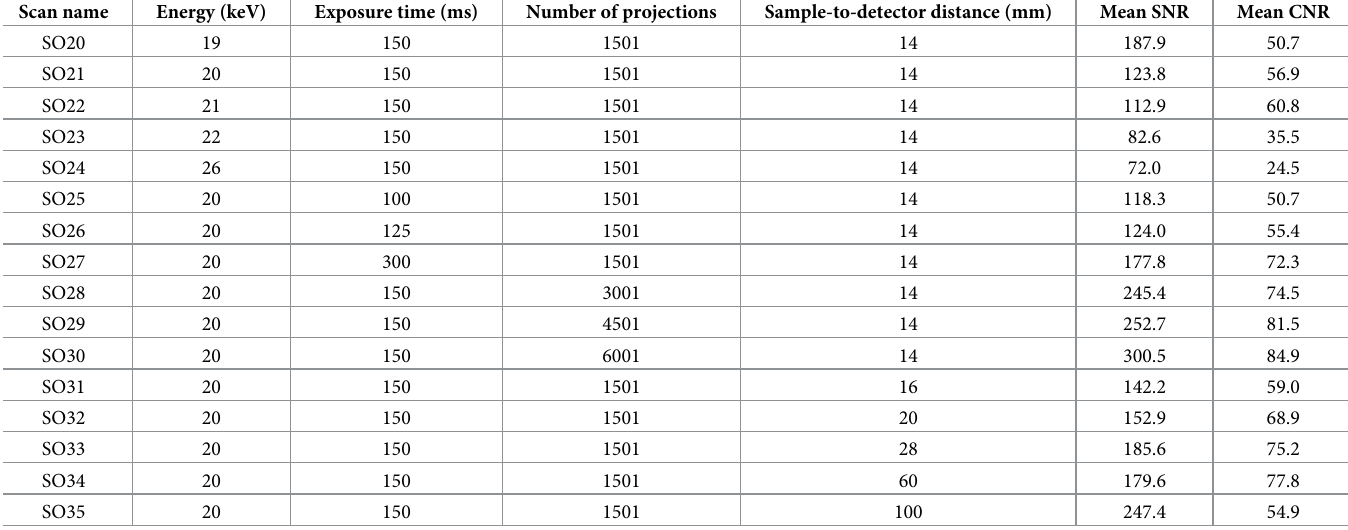
Table 2. Image quality assessments of PPCI SR CT images using different experimental